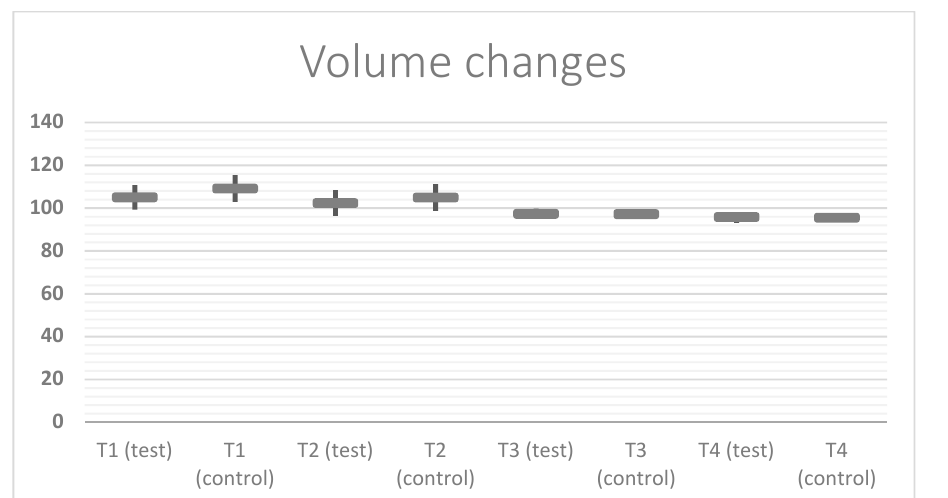
Figure 1. This is a figure showing the mean ± SD (standard deviation) of the volume changes from 100 % (baseline) of the soft tissue around the extracted tooth. The following scheme shows the statistically significant differences between the test and control groups at T 1 ( p value = 0.0380) and the slight differences at T 2 ; the trend is similar at T 3 and T 4 .